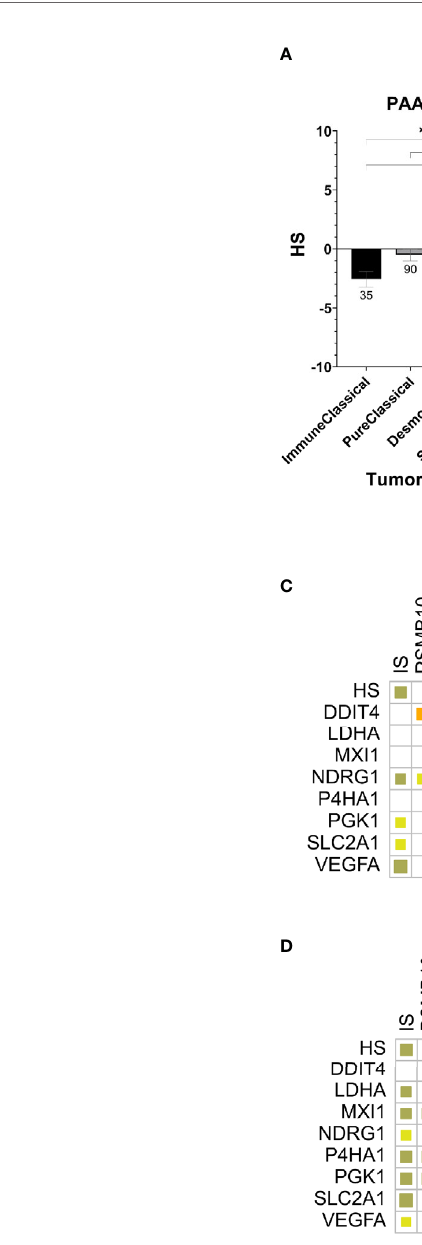
FIGURE 3 | Hypoxia and immune markers in pancreatic cancer: (A) Mean SEM of hypoxia scores in tumors based on their molecular classi fi cation. (B) Mean SEM of immune scores (IS) based on the eighteen-gene tumor in fl ammation signature in HS high and low tumors. Spearman correlation plots between expression levels of the hypoxia signature and the tumor in fl ammation signature gene sets, as well as the immune score (IS) and hypoxia score (HS) in PAAD Data-1 (C) and PAAD Data-2 (D) . Strength of correlation re fl ected in the size of the colored square and white squares indicate no correlation (C, D) . Number of samples in each group is indicated above the error bars (A, B) . Signi fi cance determined by ordinary one-way ANOVA with Bonferroni correction for multiple testing (A) and two-tailed unpaired t-test analysis (B) . P-value < 0.05 considered statistically signi fi cant. *p-value > 0.01; **p-value < 0.0021; ***p-value < 0.0002;